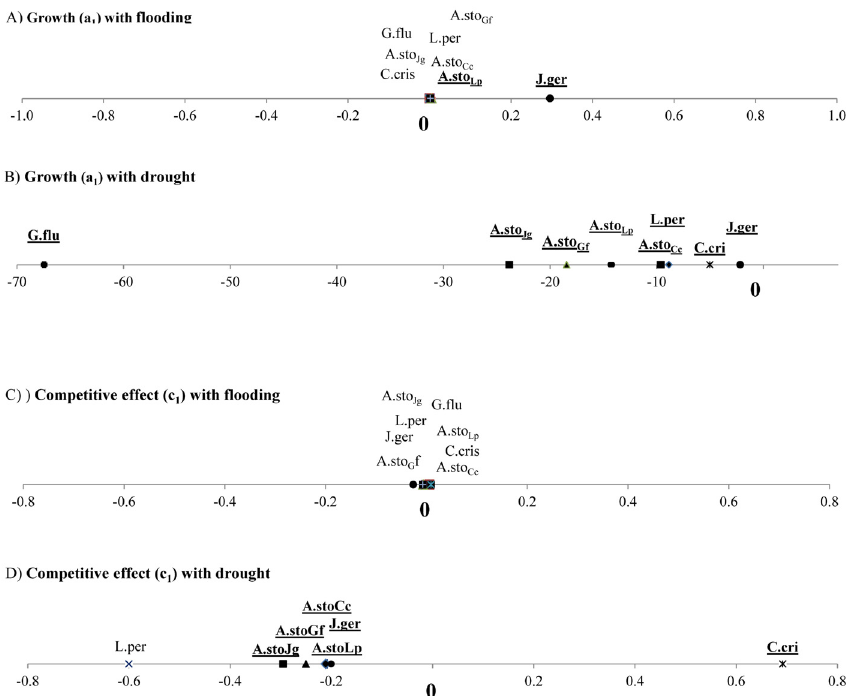
Fig 1. Median of a 1 estimating specific plant growth and c 1 , estimating species competitive effect, along flooding (A, C) and drought gradients (B, D). A positive value indicates that flooding (drought) promotes growth or competitive effect while negative value indicates a detrimental effect of flooding (drought) on growth or competitive effect. Species name for which the trend is significant appear in bold and is underlined. For Agrostis stolonifera , growth and competitive effect are reported with the model run with four different species for which the initials appear in subscript (A.sto Lp , A.sto Cc , A.sto Jg , A.sto Gf